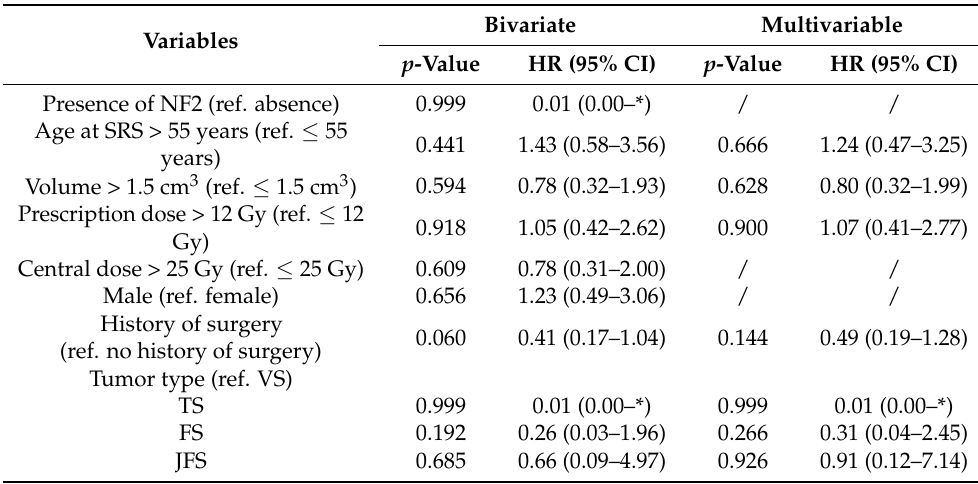
Table 2. Results of bivariate and multivariable analyses of tumor progression before